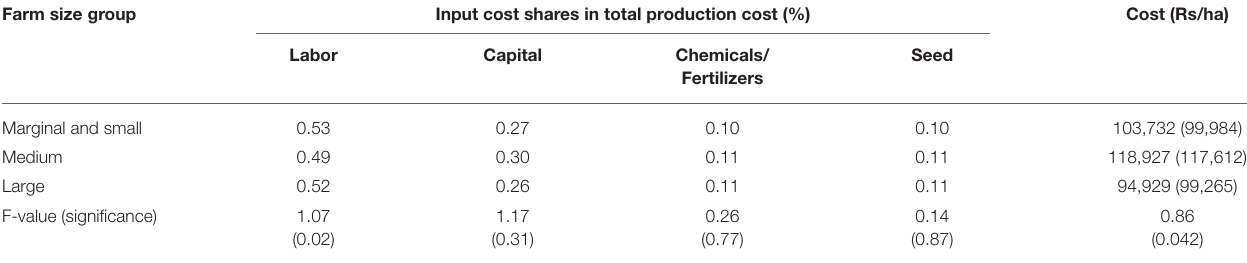
TABLE 8 | Cost of production and inputs cost shares (%) by farm size group, Nepal.